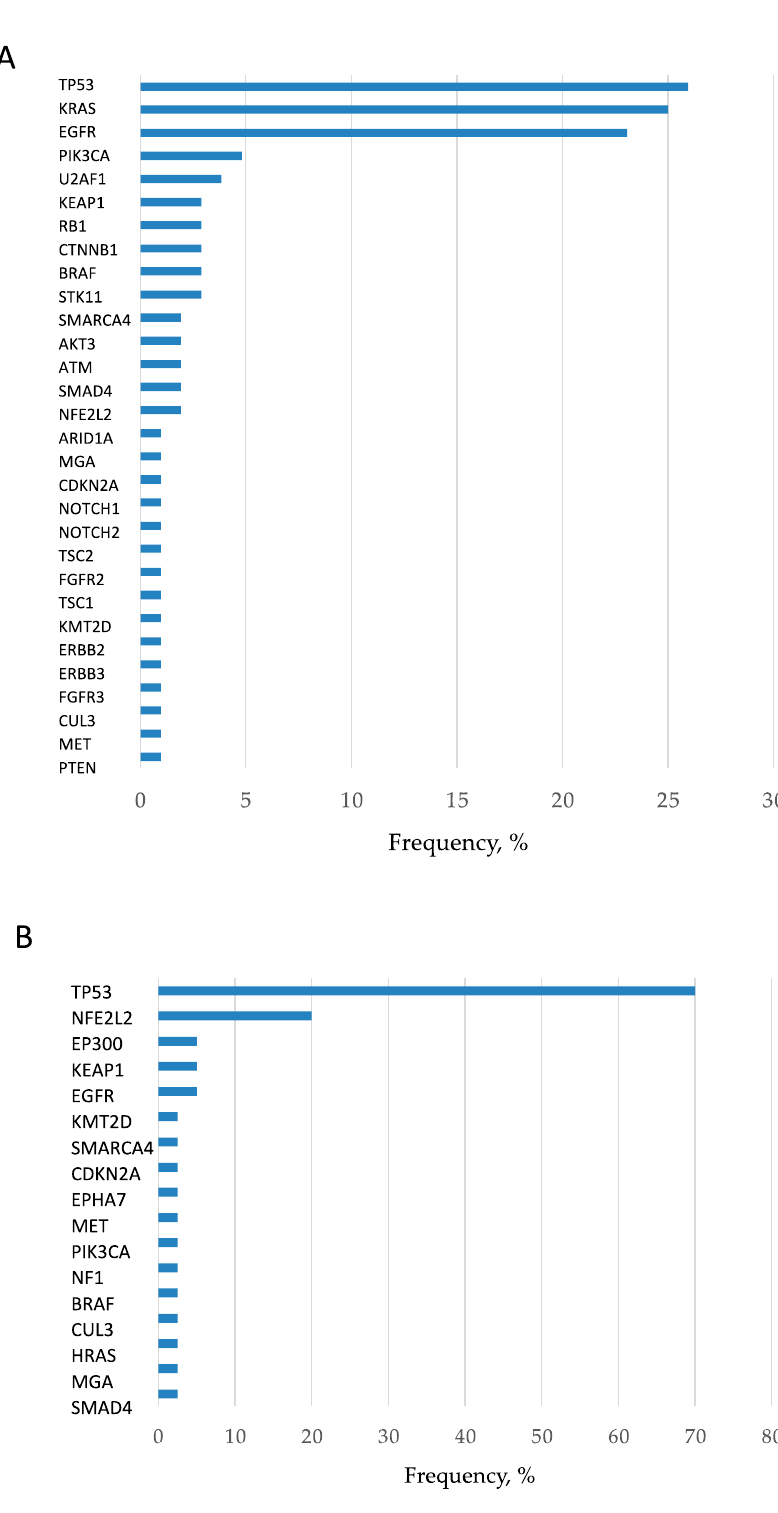
Figure 2. Frequency of detection of pathogenic mutations in adenocarcinomas and squamous cell carcinomas. ( A ) Pathogenic mutations with AF of >20 in adenocarcinomas are presented. The frequencies of TP53 , KRAS , and epidermal growth factor receptor ( EGFR ) mutations were remarkably high, and hence they can be considered the three major mutations. ( B ) Pathogenic mutations with AF of >20 in squamous cell carcinomas are presented. The frequency of TP53 mutation was remarkably high.